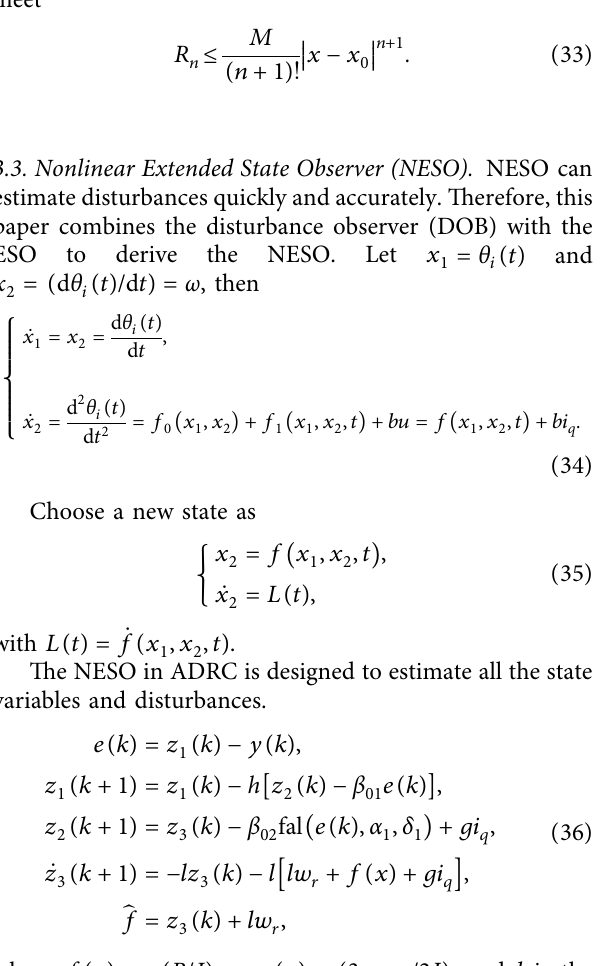
Figure 3: The schematic diagram of phase delay. Table 1: Parameters in the